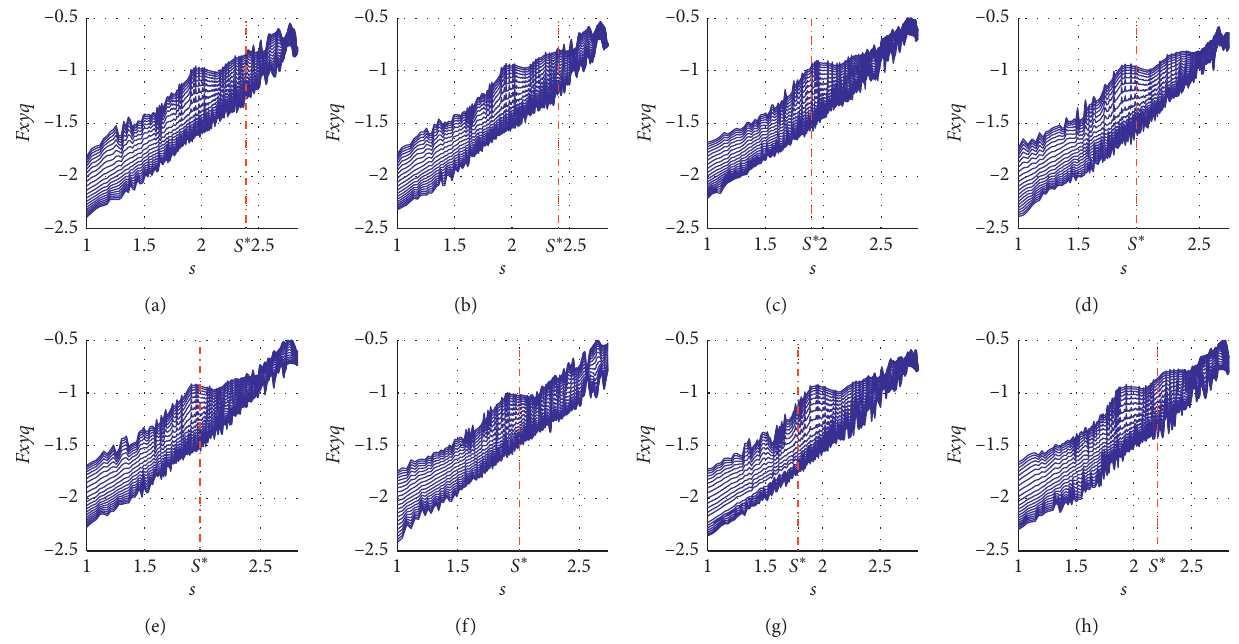
Figure 4: Log-log plots of log ( F ( s )) versus log ( s ) for the developed (developing) financial markets return and online sentiment: (a) US: q SP500, (b) US: Nasdaq, (c) Brazil: BVSP, (d) Indonesia: JKSE, (e) Japan: Nikkei, (f) Germany: DAX, (g) Mexico: MXX, and (h) India: BSE. Table 2: Average value of scaling cross-correlation exponents ( q ) for the stock market returns and online sentiment in H xy developed and developing